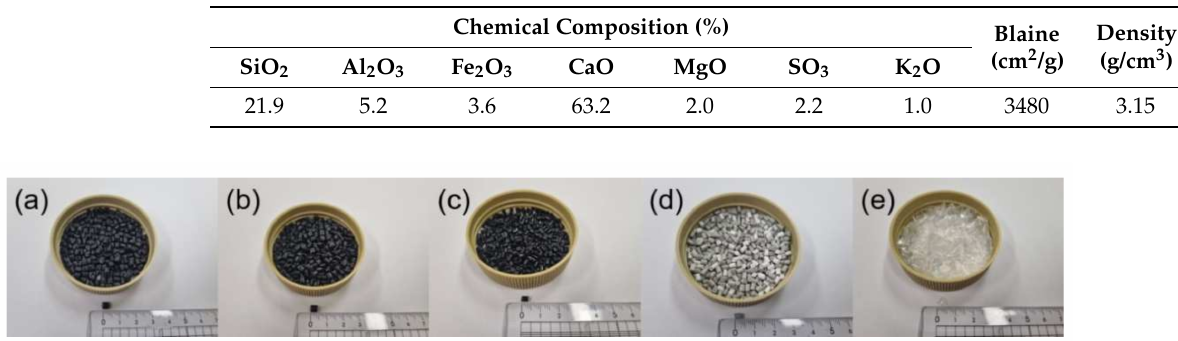
Table 3. Chemical compositions and physical properties of cement.